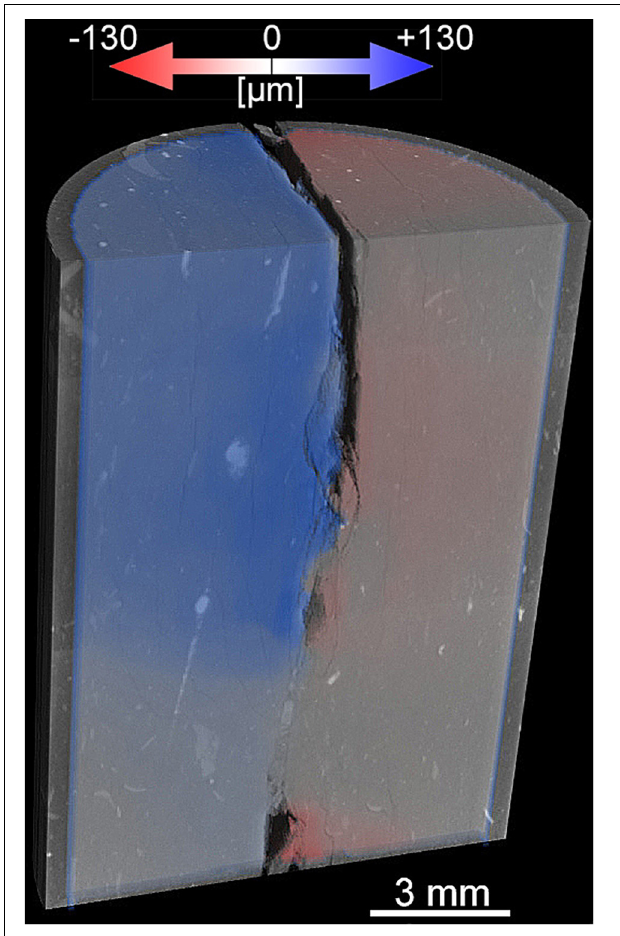
FIGURE 4 | Digital volume correlation of the sample before and after hydraulic sealing (lower half of the sample. A colormap of the local displacements along the direction perpendicular to the fracture plane has been superimposed to the sample volume